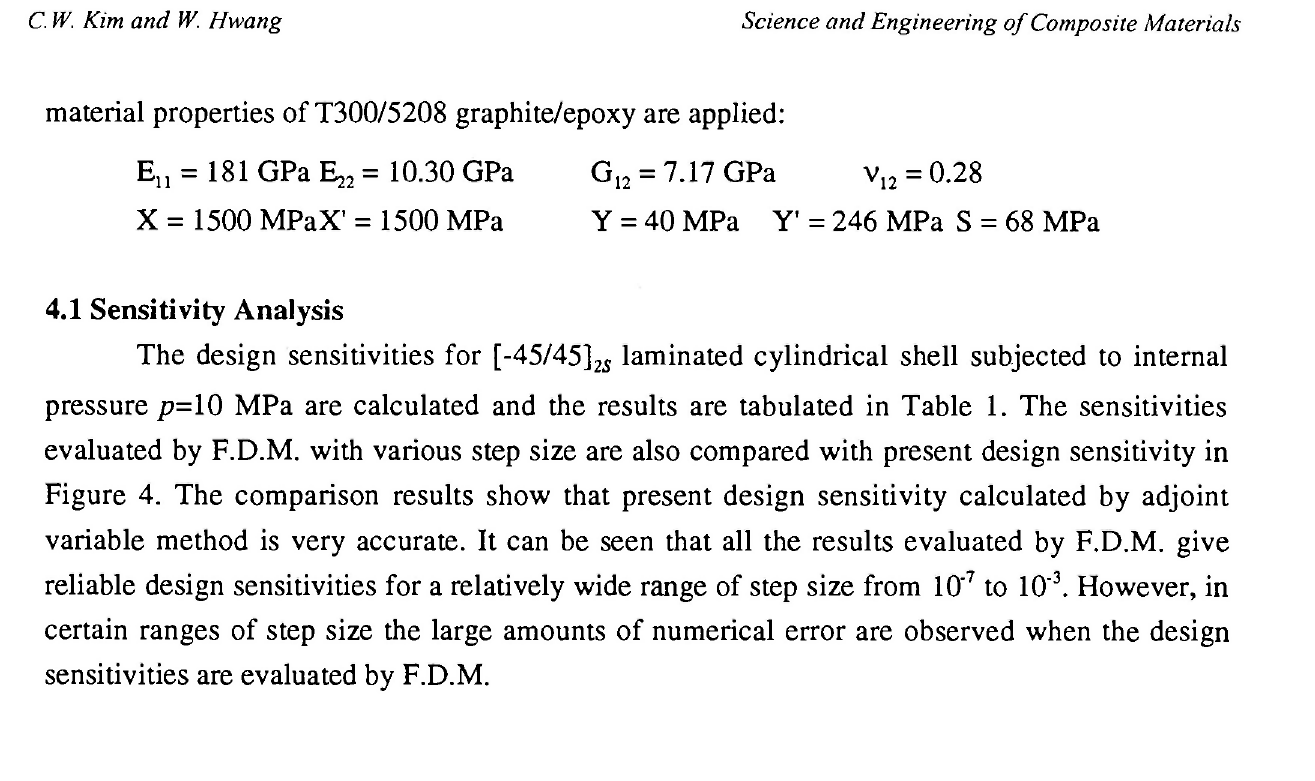
Laminated Shell ( step size is 2S